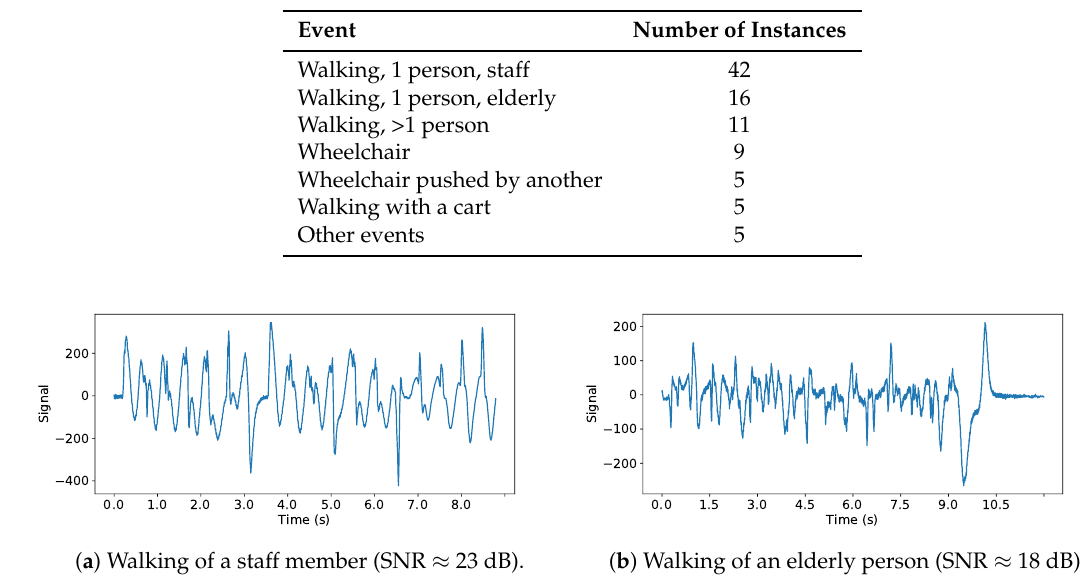
Figure 9. Example of signal of a young healthy person from the staff ( a ) and an elderly ( b ). The first observation is that the signal generated by the elderly footsteps has a significantly smaller amplitude, leading to a lower signal-to-noise ratio. We recognize some similarities between these signals as step patterns, as can be seen in ( b ). However as a whole, the ( b ) signal seems less repeatable than ( a ). This is probably due to the fact that the walking of an elderly can be less regular and less pronounced than a young healthy person whose feet leave and hit the floor at a regular